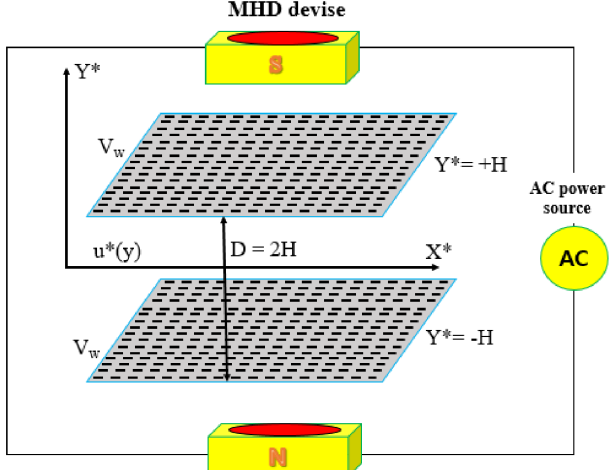
Figure 1. Schematic diagram and the coordinate system for the considered